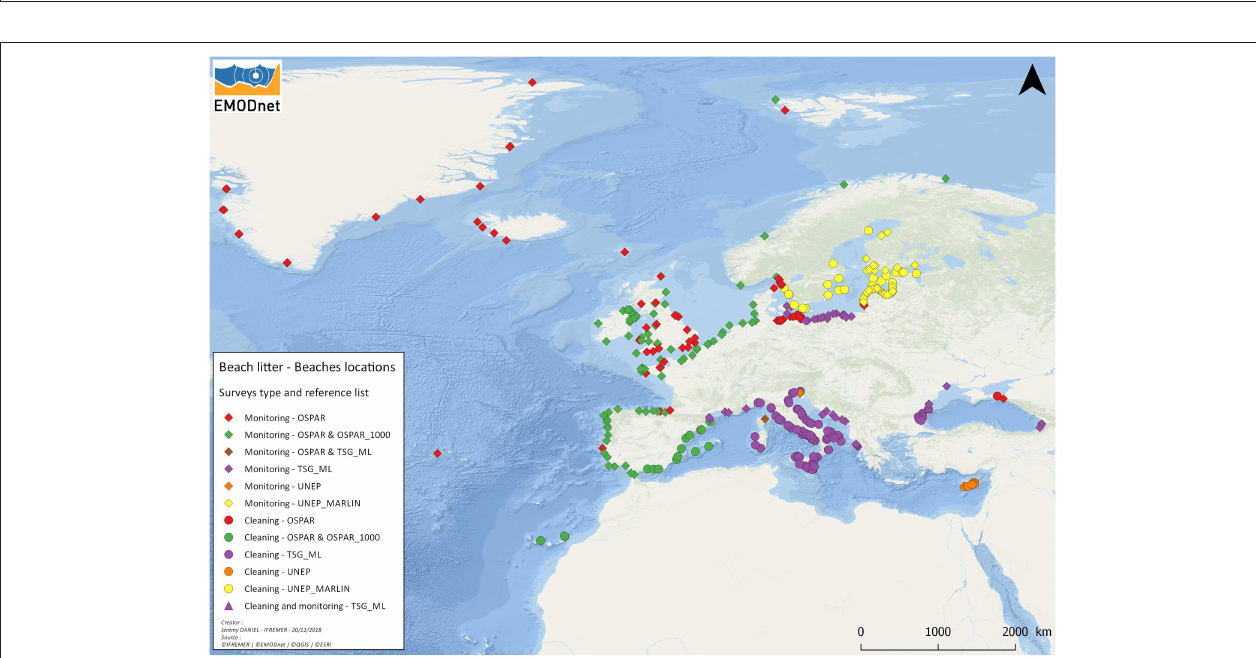
FIGURE 10 | Spatial distribution of surveyed beaches, and reference lists used for litter items in EMODnet and cleaning/monitoring sites (The EMODnet Chemistry project, whose PIs are among the authors of this paper, holds the copyright on this figure).